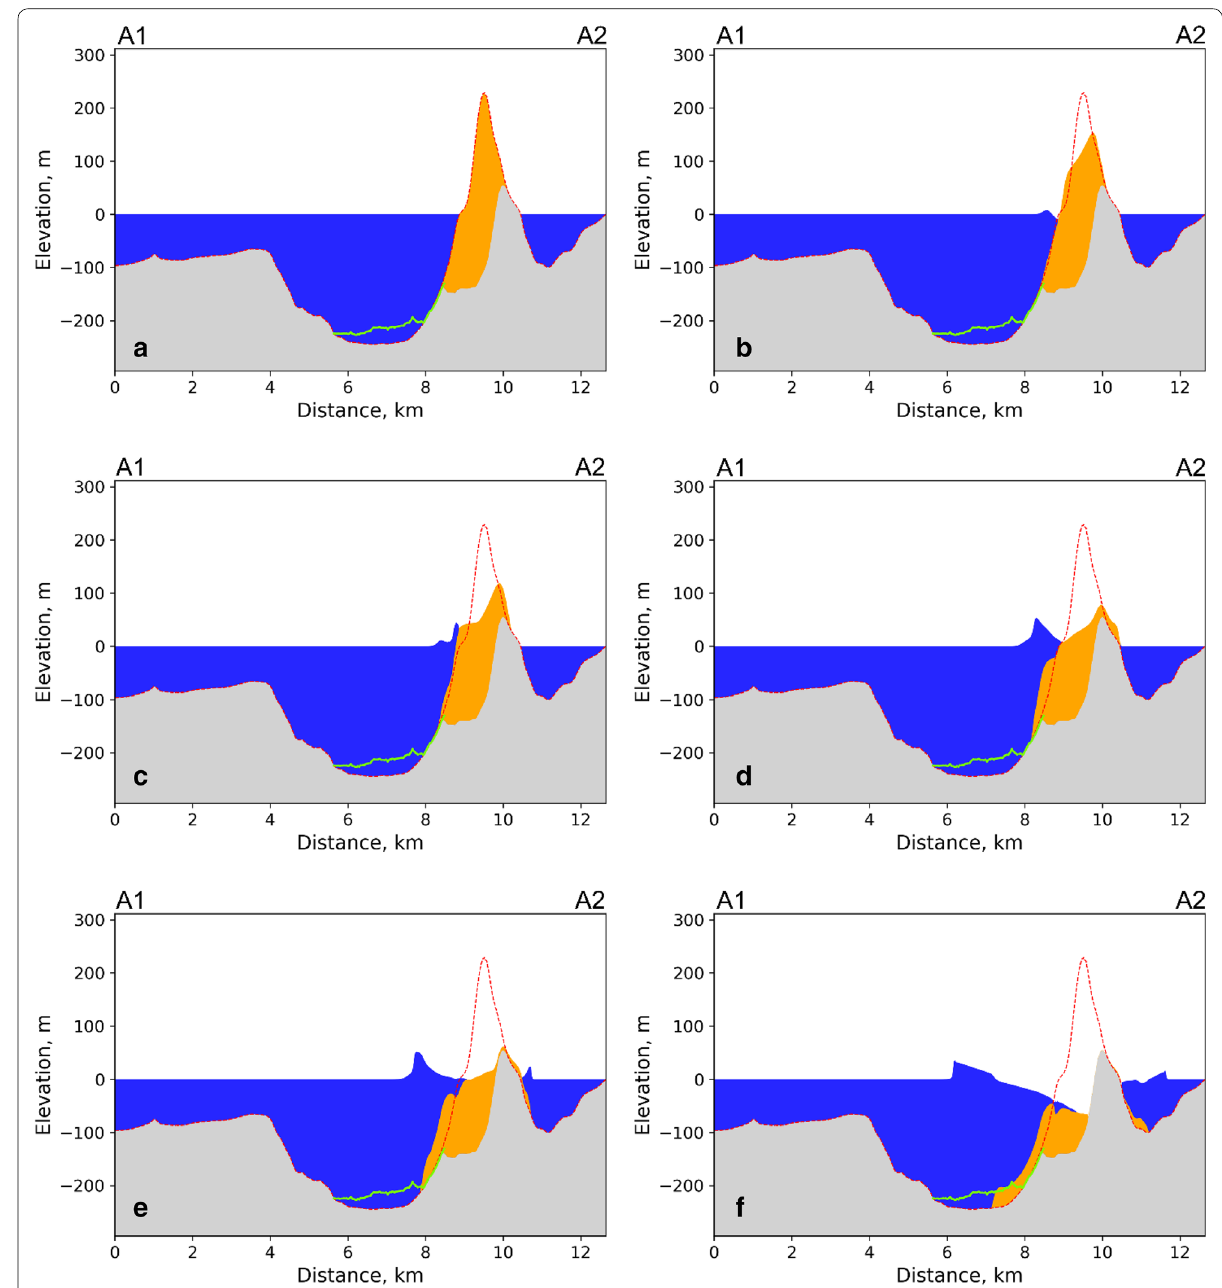
Fig. 8 Temporal evolution of the tsunami from the optimum landslide parameters after a 0 s, b 5 s, c 10 s, d 20 s, e 30 s, and f 60 s. The red line is the topography/bathymetry before the event, and the green line is the observed bathymetry after the